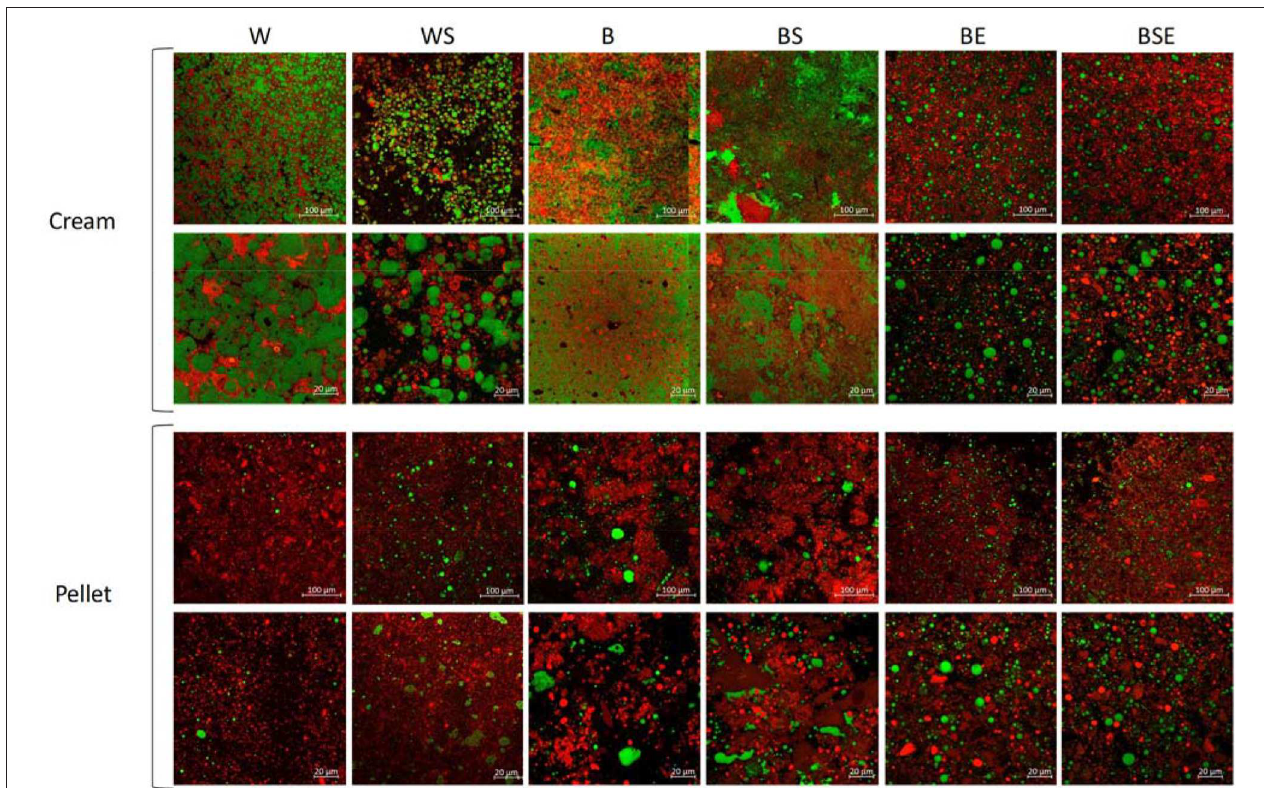
FIGURE 7 | Confocal microscopy of cream and pellet 20x and 63x magnification from W, washed larvae; WS, washed sonicated; B, blanched; BS, blanched sonicated; BE, blanched enzymatically treated; BSE, blanched sonicated enzymatically treated. Red color indicates protein, green color indicates